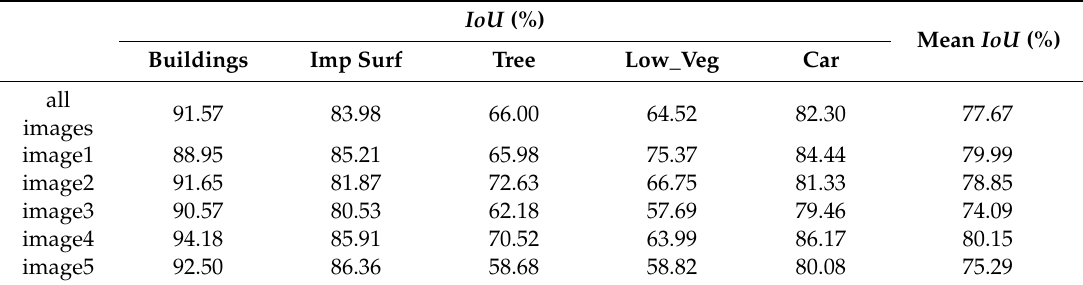
Table 2. The results of IoU and Mean IoU on all the validation